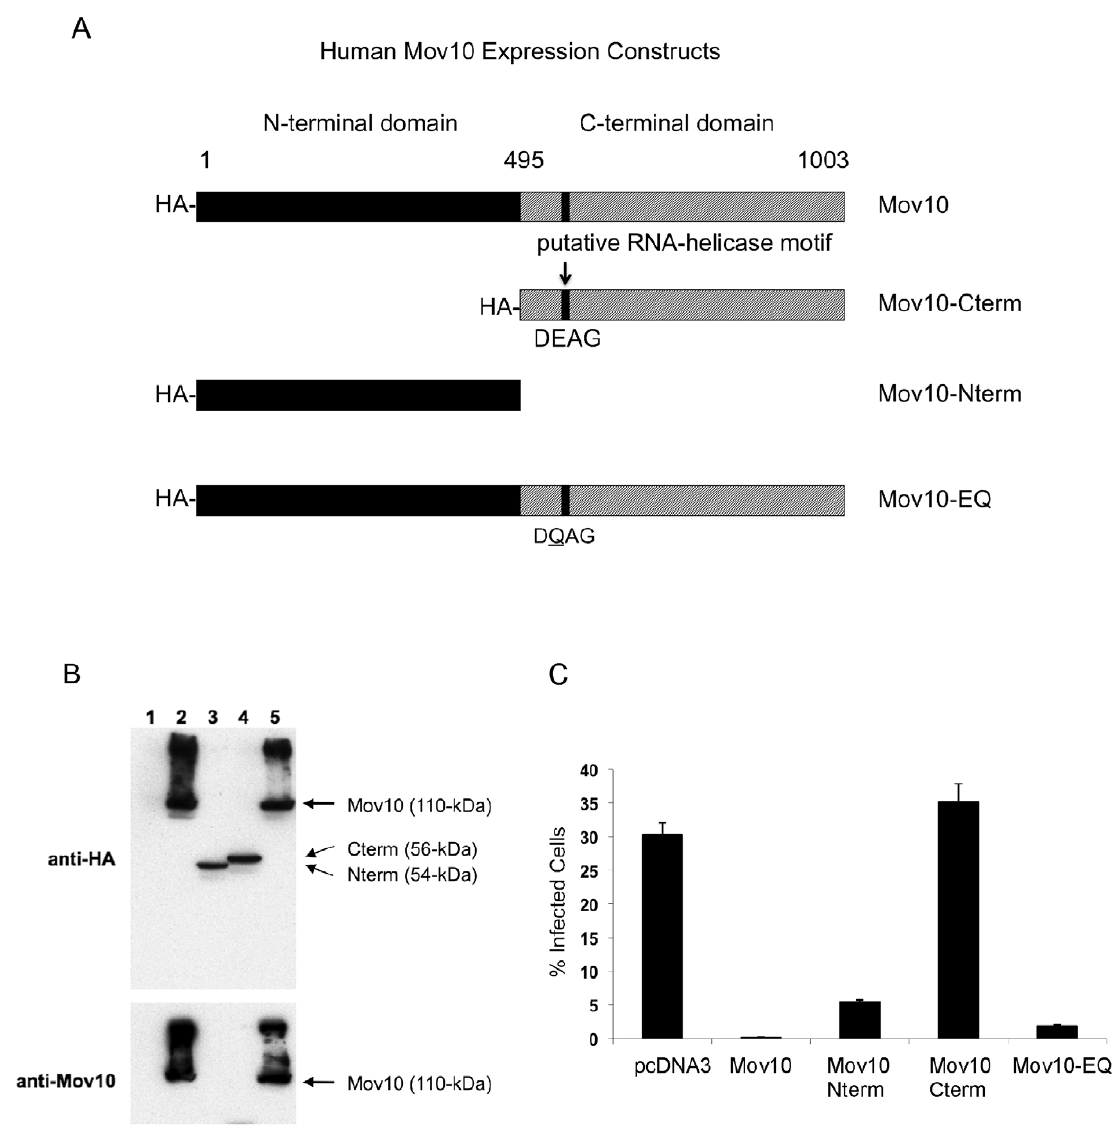
Figure 8. The helicase domain of Mov10 is not required for HIV-1 restriction. Virions were produced by cotransfection of 293T cells with HIV-1 vector and either empty vector or Mov10, Mov10 N-terminus, Mov10 C-terminus or the putative helicase motif mutant expression plasmids. ( A ) Schematic of wild-type and mutated human Mov10 constructs. ( B ) Cell lysates were probed with anti-HA, anti-Mov10, and anti-tubulin. Lanes: 1) pcDNA3, 2) Mov10, 3) Mov10 Nterm, 4) Mov10 Cterm, and 5) Mov10-EQ. Arrows indicate molecular weight of native Mov10. ( C ) Infectivity of